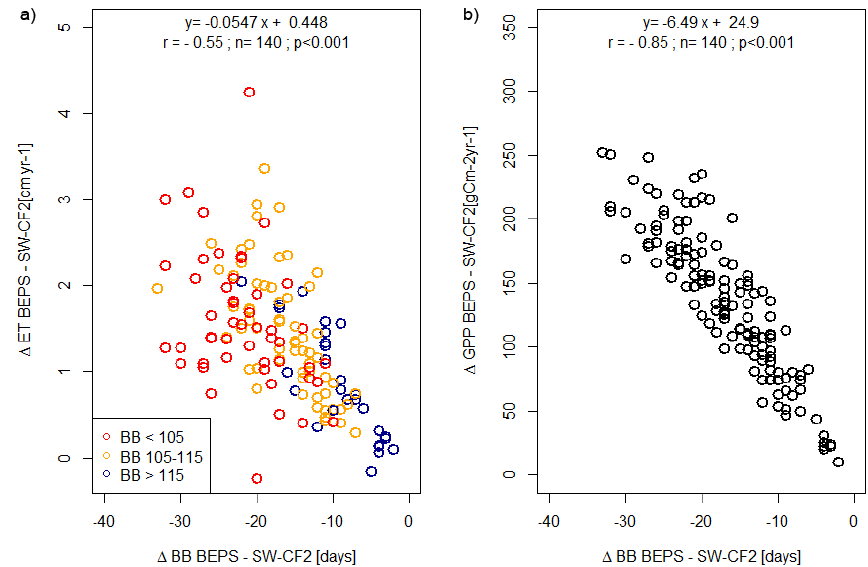
Fig. 9. Relationships between differences in BB ( 1 BB) simulated with the best model (SW-CF2 as described in Table 1) and the internal phenological routine of BEPS and the differences in annual ET (a) and GPP (b) simulated with reference run and BEPS SW - CF2 (Table 4). In (a) circles are represented with different colors according to the BB date simulated with the internal routine of BEPS. p < 0 . 001) when the bud-burst occurs late (bud-burst > 115) while they are poorly correlated ( r = − 0 . 38, p < 0 . 01)